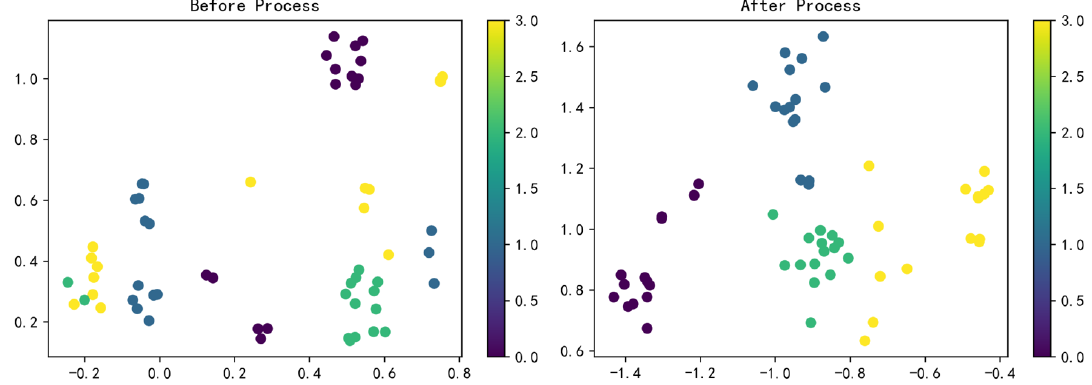
Figure 8. T-SNE of test samples before and after the model learning